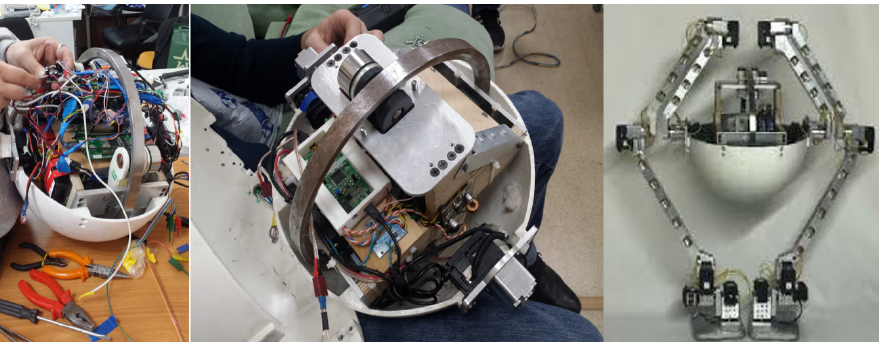
Figure 2. AnyWalker mobile robot: the left picture and the central picture demonstrate the electronic insides of the robot “head”, and the right picture demonstrates the standing prototype of the robot without the top casing of the “head”.